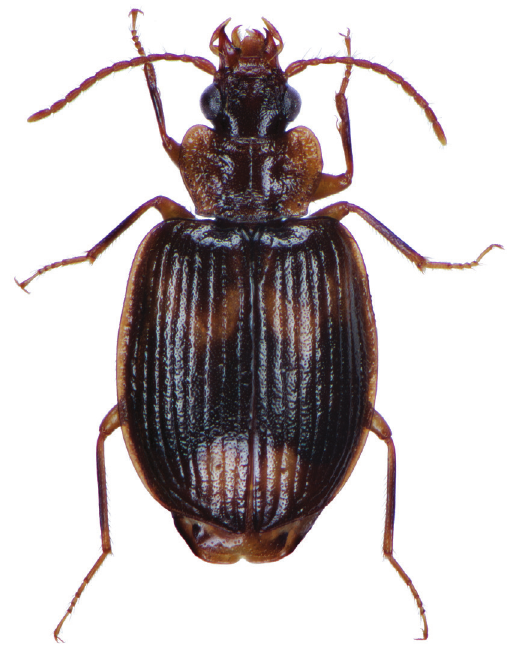
Figure 75. Dorsal habitus and color pattern of Formosiella flavomaculata (Shibata). (OBL 5.12